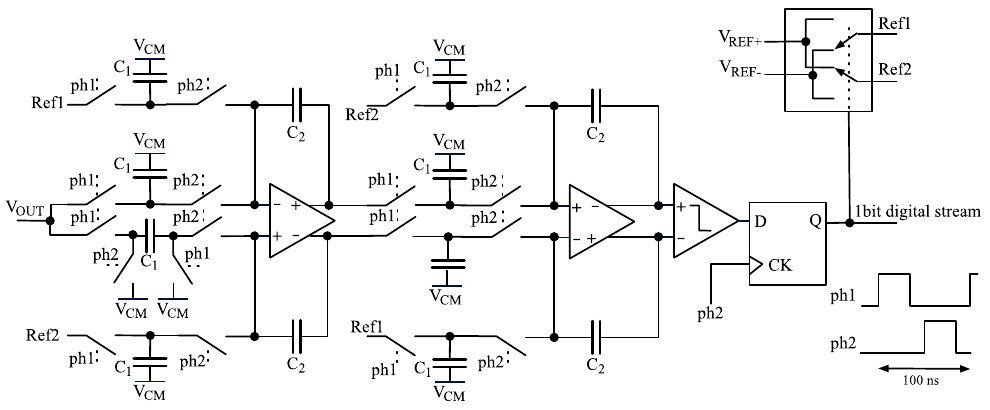
Figure 7. Schematic diagram of the second-order ΔΣ converter. V CM is half the power supply.